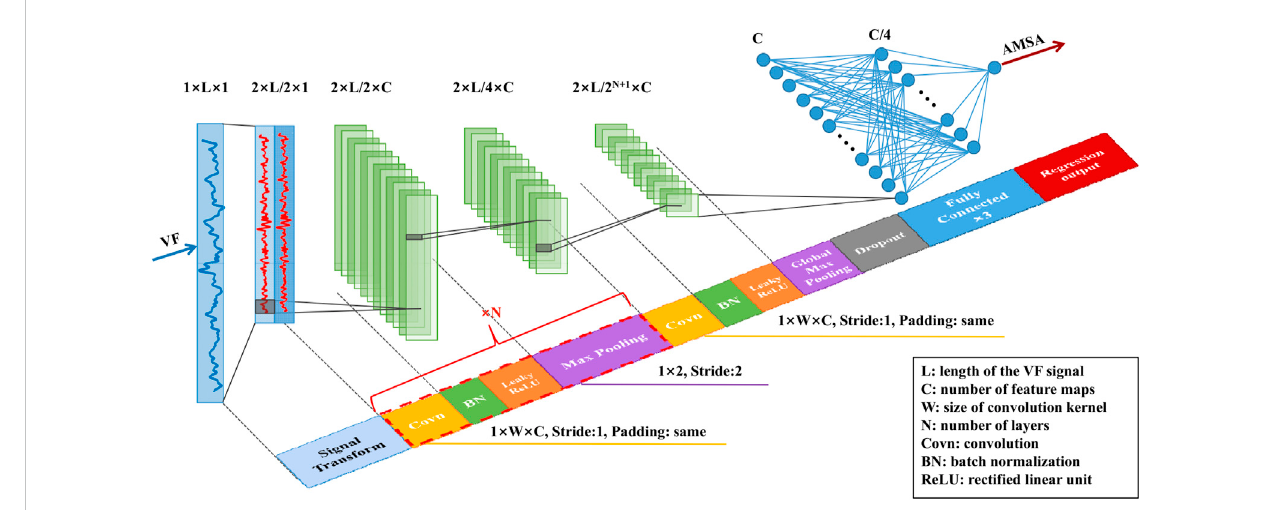
Architecture of the proposed